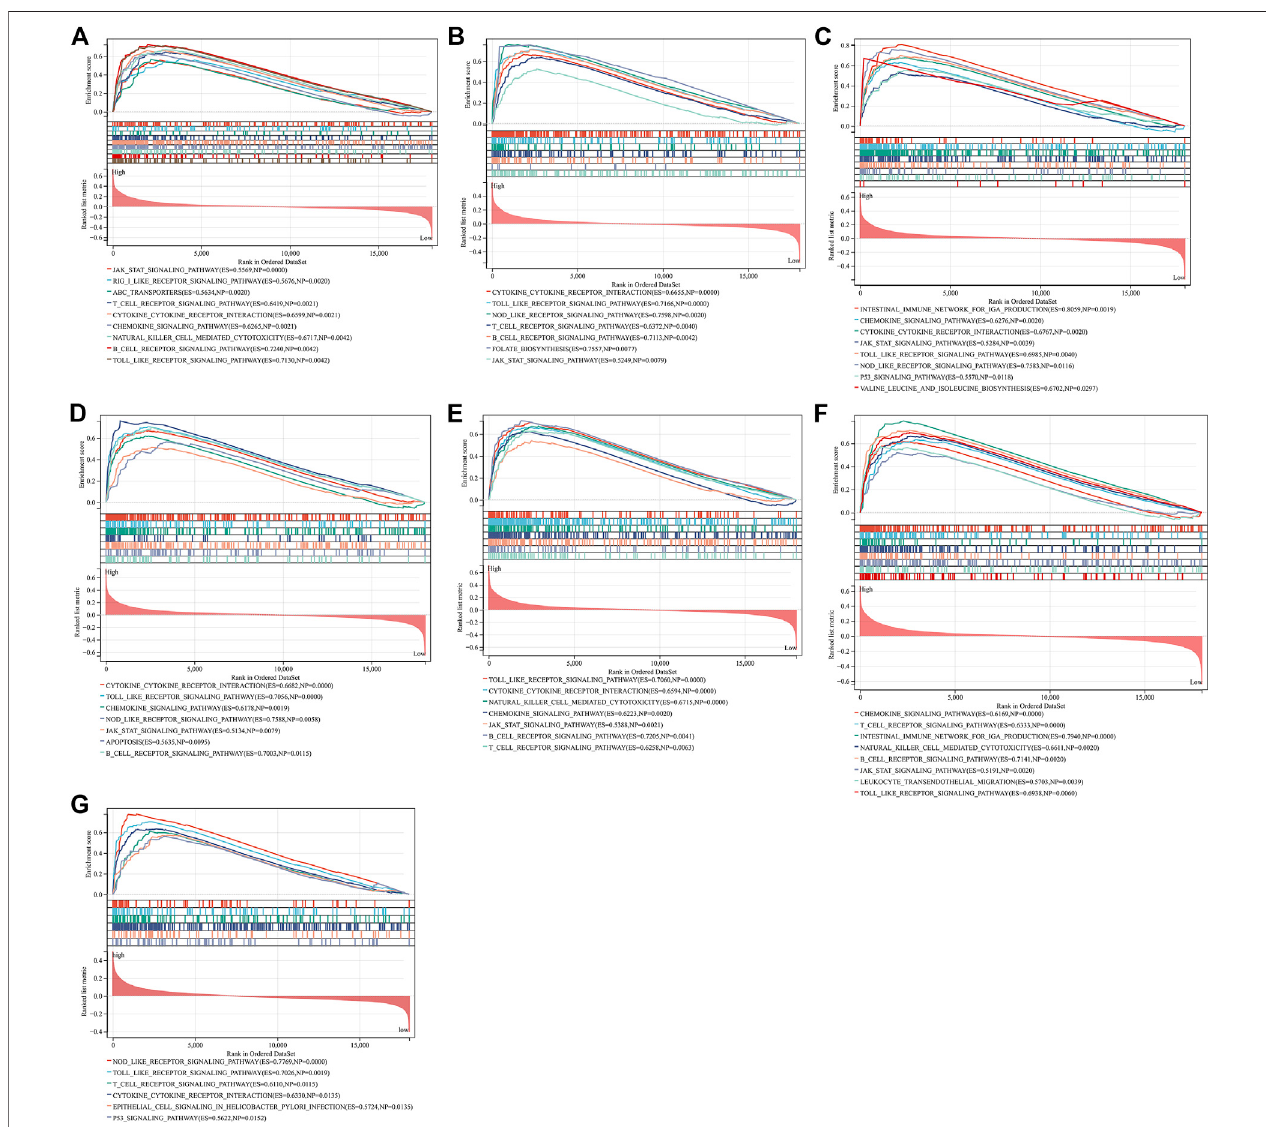
FIGURE 6 | GSEA identi fi es signaling pathways involved in the characteristic genes. (A – G) The main signaling pathways that are signi fi cantly enriched in high expressions of characteristic genes (A) BTK, (B) CCL5, (C) CCL19, (D) CD14, (E) GZMB, (F) ITGAL, and (G) TNFSF13B.